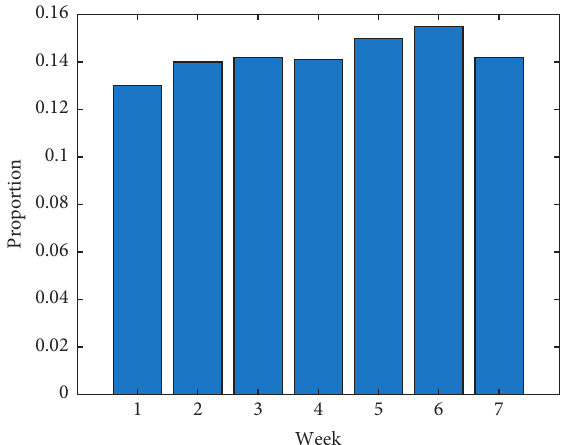
Figure 2: Weekly distribution of user sign-in.